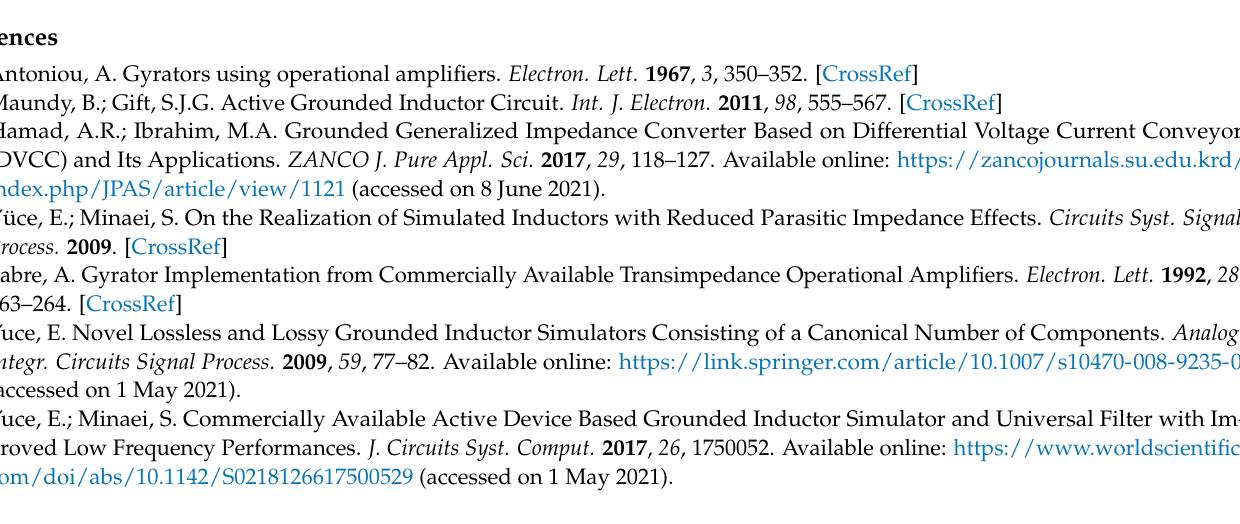
Figure 22. A time-domain analysis for the band-pass filter.